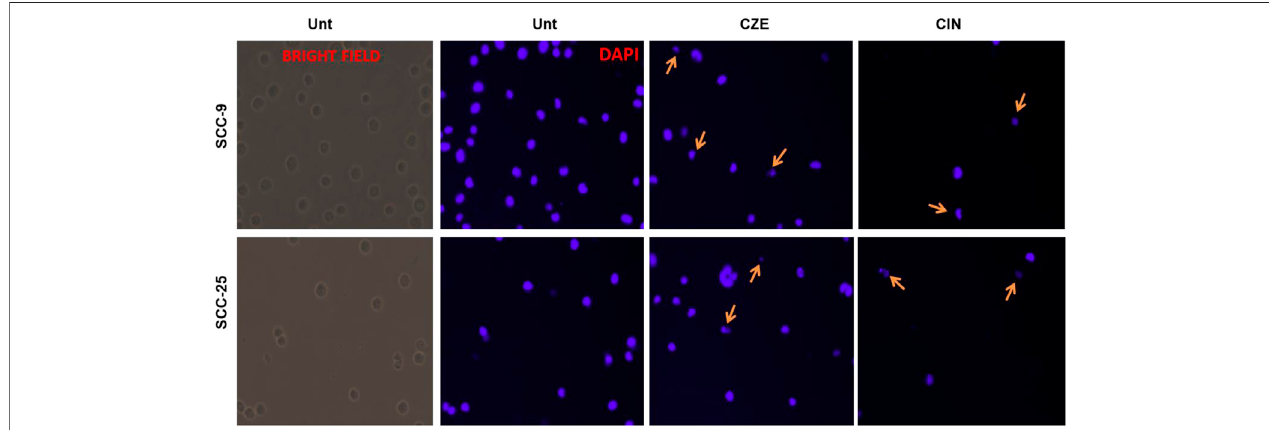
FIGURE 6 | Photomicrographs showing DAP-I Staining The untreated SCC-9 and SCC-25 cells showed normal nuclear morphology, whereas CZE and CIN treated cells underwent nuclear fragmentation and cell shrinkage (as shown by arrows) (40X). CIN treatment induces autophagy in oral cancer cells.